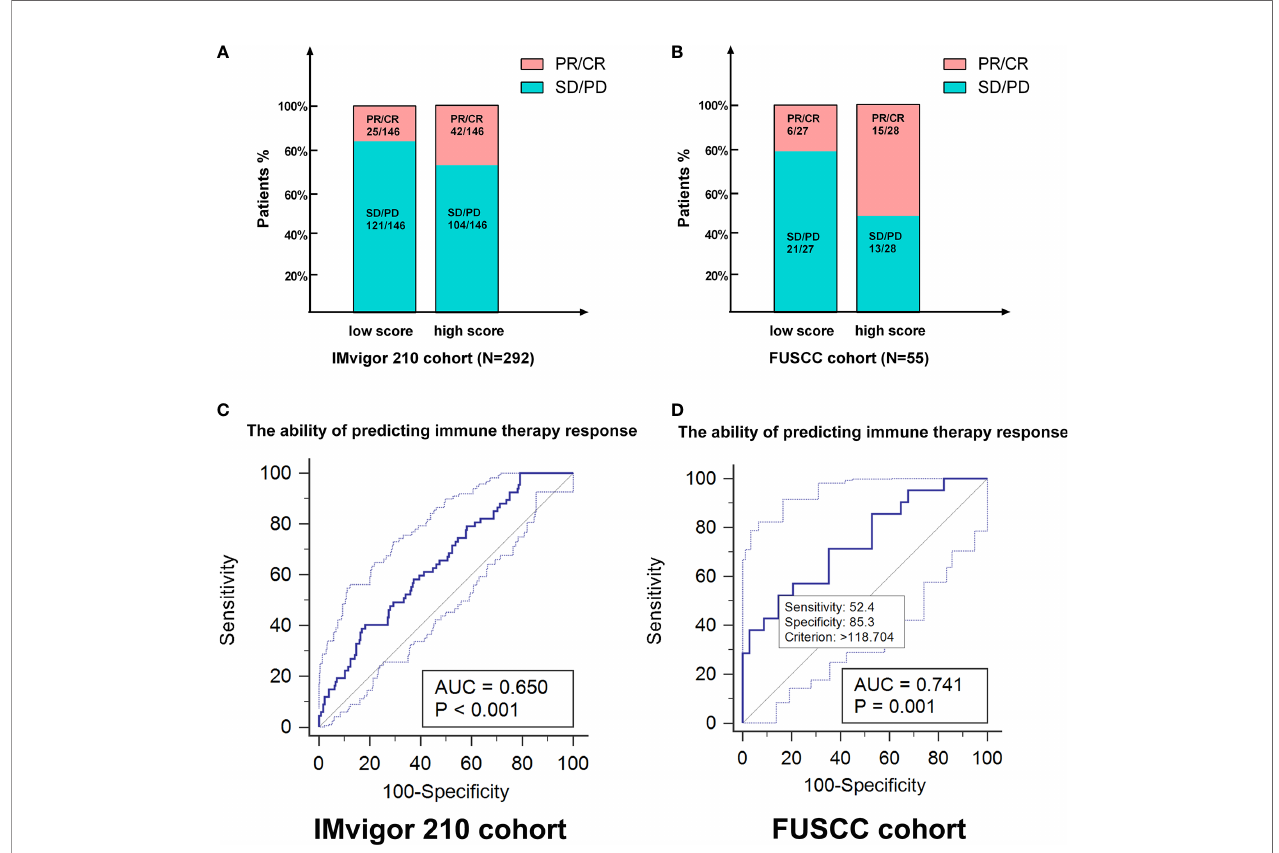
FIGURE 7 | The genomic classi fi er showed strong ability in predicting ICTs response based on testing and validation cohorts. (A, B) As the cluster 3 was of signi fi cant suppressive microenvironment, we tended to construct a genomic classi fi er and explored its ability of predicting ICTs response. The classi fi er could stratify the patients into m6A scoreLow (cluster 1&2) and m6A scoreHigh (cluster 3) group. (C, D) ROC curves indicated that the genomic classi fi er has a good accuracy and stability predicting responses to ICTs (IMvigor210 cohort: AUC=0.65, p < 0.001; FUSCC cohort: AUC=0.742, p <